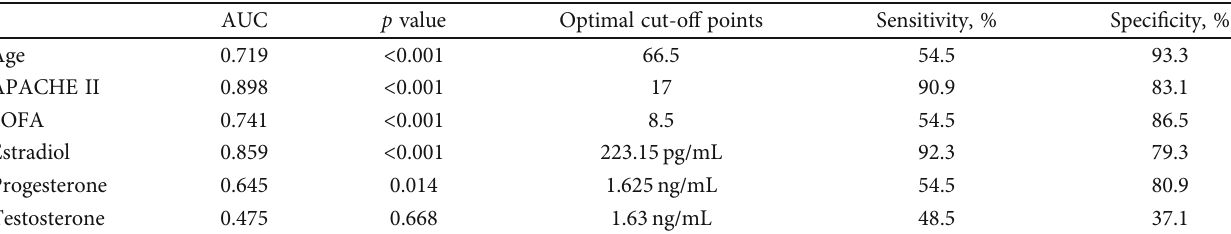
Table 4: Diagnostic e ffi ciency of age, APACHE II score, SOFA score, and serum hormone levels for of AKI in patient with MSAP and SAP. AUC p value Optimal cut-o ff